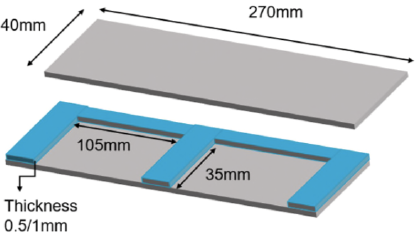
Figure 2. Schematic of the manufactured mould.